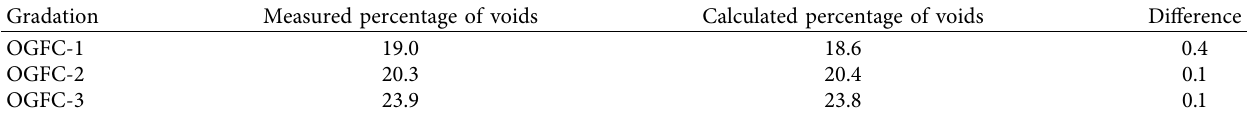
Table 7: Measured percentage of voids and calculated percentage of